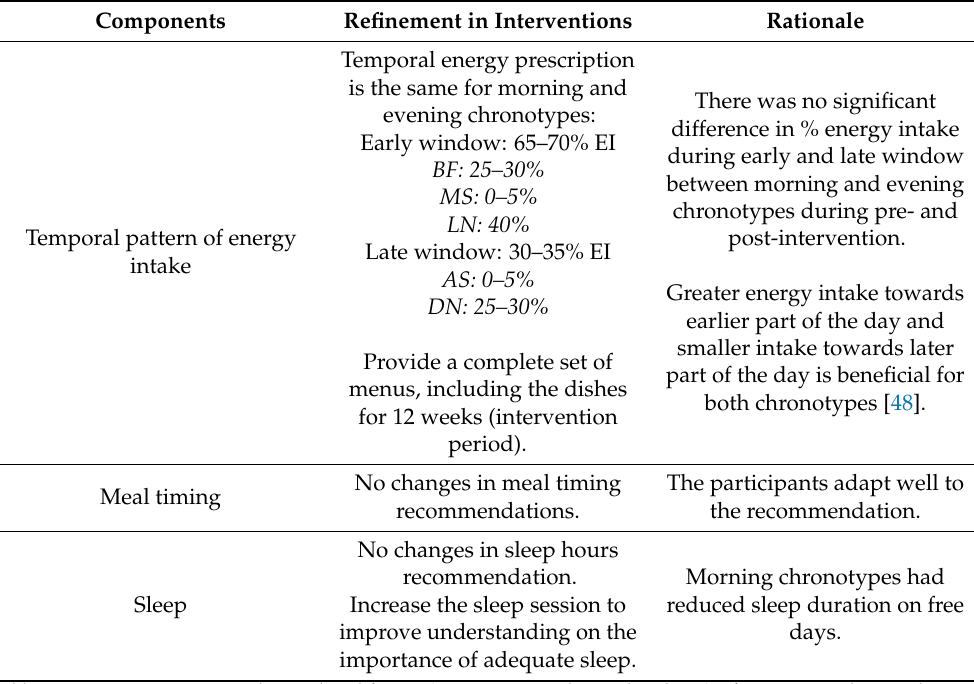
Table 6. Refinement in chrono-nutrition components based on the feasibility